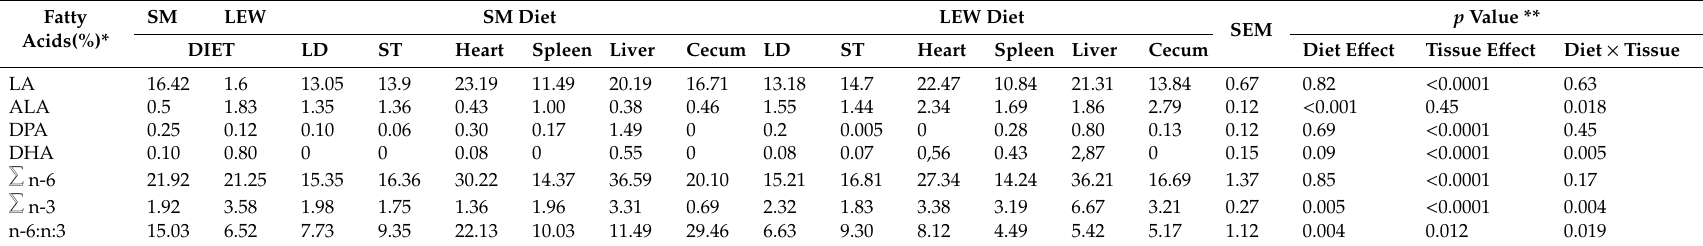
Table 5. E ff ect of dietary extruded linseed:walnut meal 50:50 ( wt / wt ) mix on centesimal fatty acid composition in longissimus dorsi (LD) and semitendinosus (ST) muscles, heart, spleen, liver and